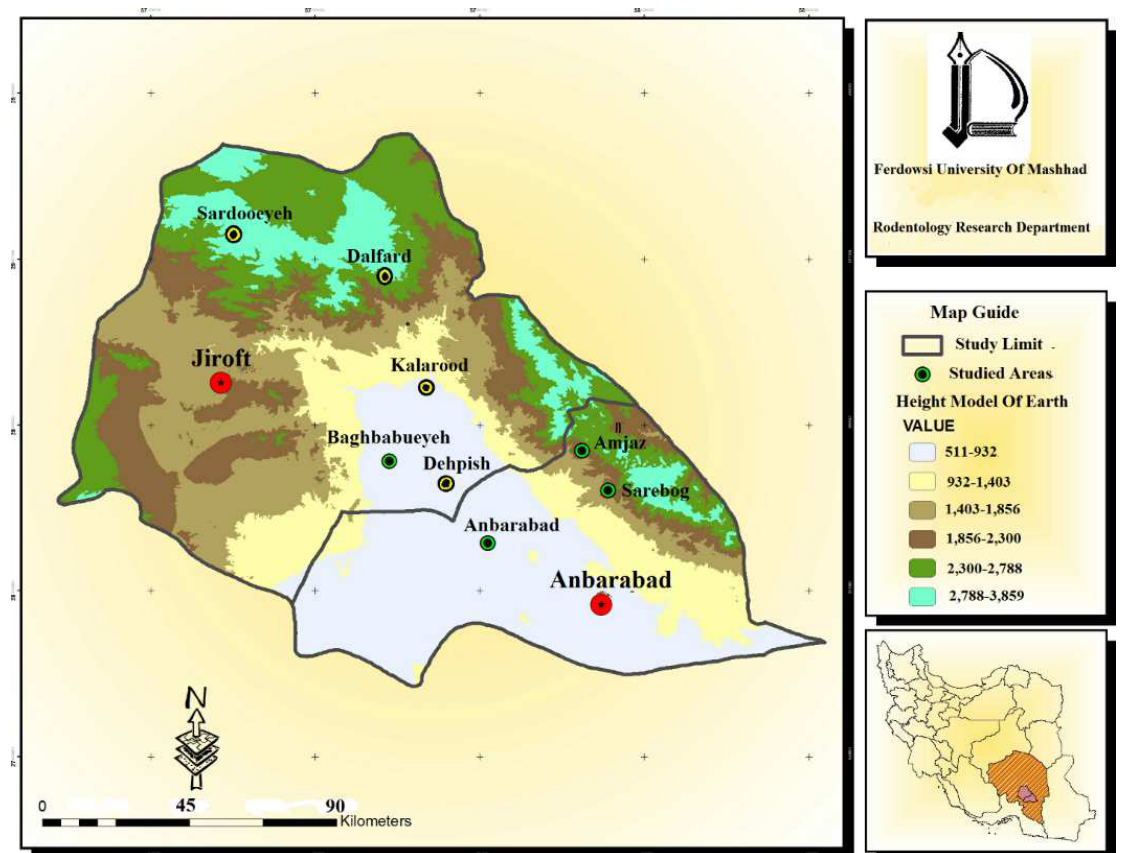
F IGURE 1. Collecting sites of specimens in Jiroft and Anbarabad